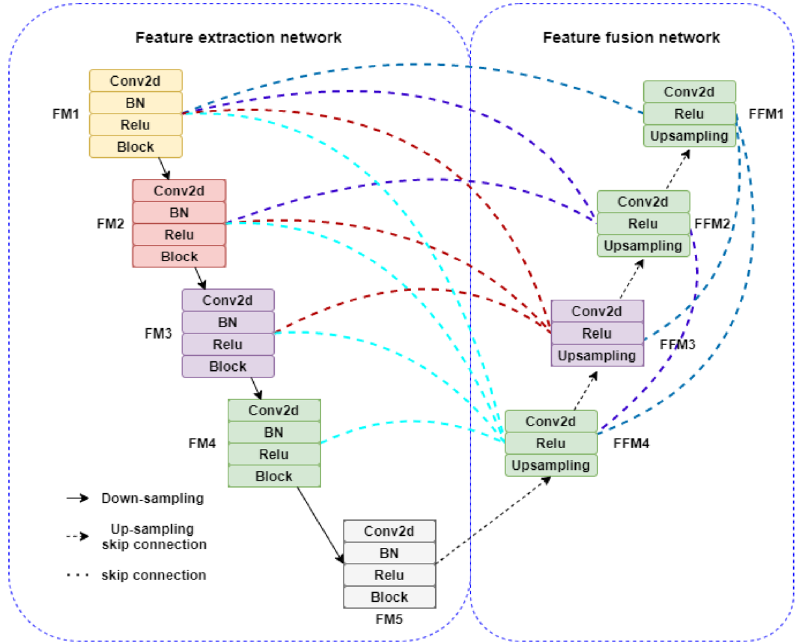
Figure 5. Unet3+ network structure after the introduction of